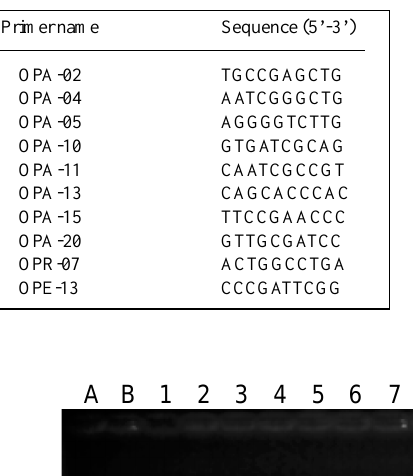
Table I - Nucleotide sequence of RAPD primers.